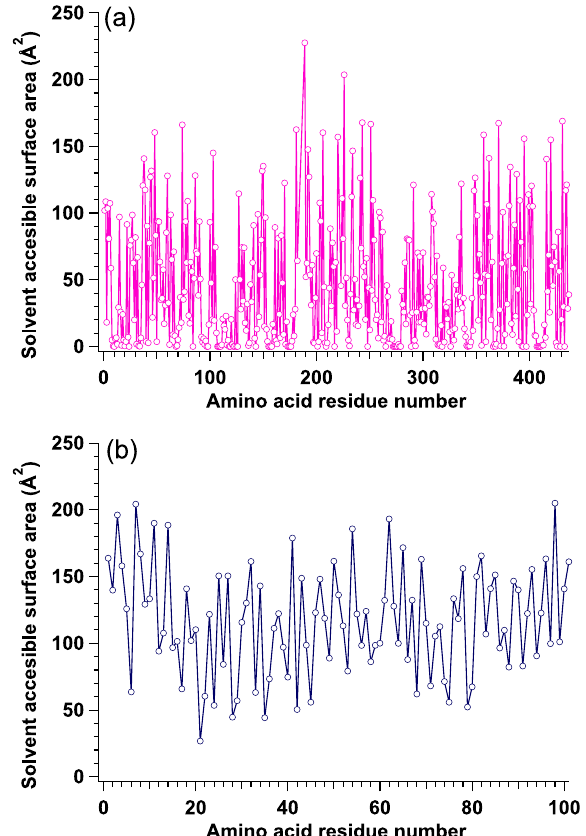
Figure 4. Solvent accessible surface area as function of amino acid residue numbers. Solvent accessible surface area as function of numbers of amino acid residues in (a) MurD and (b) Hef-IDR. This figure is prepared by the usage of IGOR Pro 6.34A (https ://www.wavem etric s.com/forum /news-and-annou nceme nts/igor-634a-now- shipp